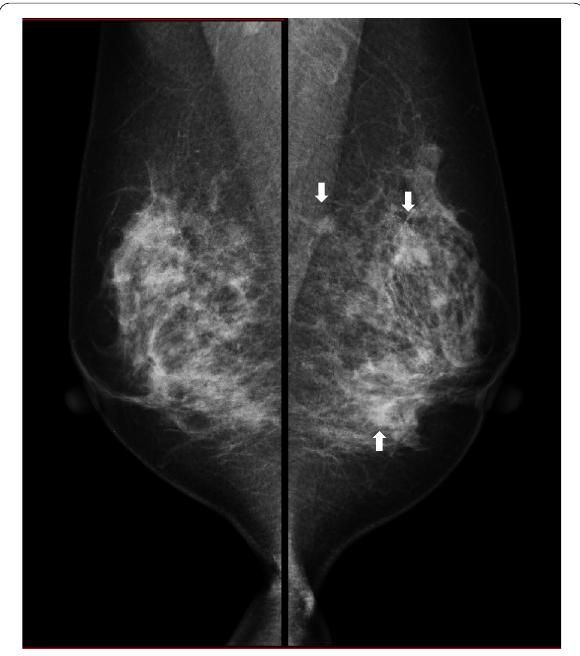
Fig. 4 Mammographic findings. Focal asymmetric density is detected in the left breast